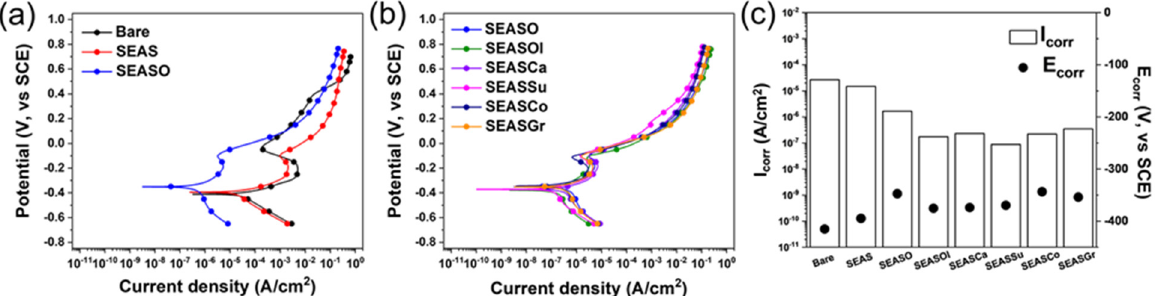
Figure 3. Potentiodynamic polarization curves in 1.0 M HCl of ( a ) bare, SEAS, and SEASO; ( b ) SEASO, SEASOl, SEASCa, SEASSu, SEASCo, and SEASGr. ( c ) Estimated corrosion current density (I corr ) and potential (E corr ).